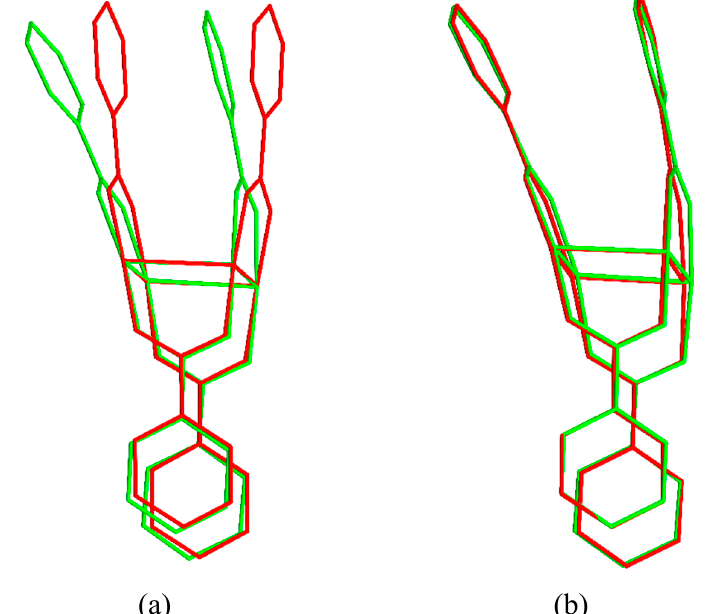
Figure 5. Overlay of the ground state geometries (S 0 ): experimental (green colour) and DFT-optimised (red colour) geometries for ( a ) isolated-molecule and ( b ) QM/MM theoretical results. (hydrogen atoms are omitted for clarity; figures shown only for molecule A; in the ( a ) panel the molecular cores are least-squares superimposed). Table 6. Lowest-energy triplet excited states computed for a single Cu 4 molecule for both the isolated molecule and QM/MM results. Symmetry labels refer to the isolated-molecule CAM-B3LYP results for the complex exhibiting D 2 point-group symmetry. Method & Excitation Energy/eV State CAM-B3LYP (isol.) QM/MM (mol.